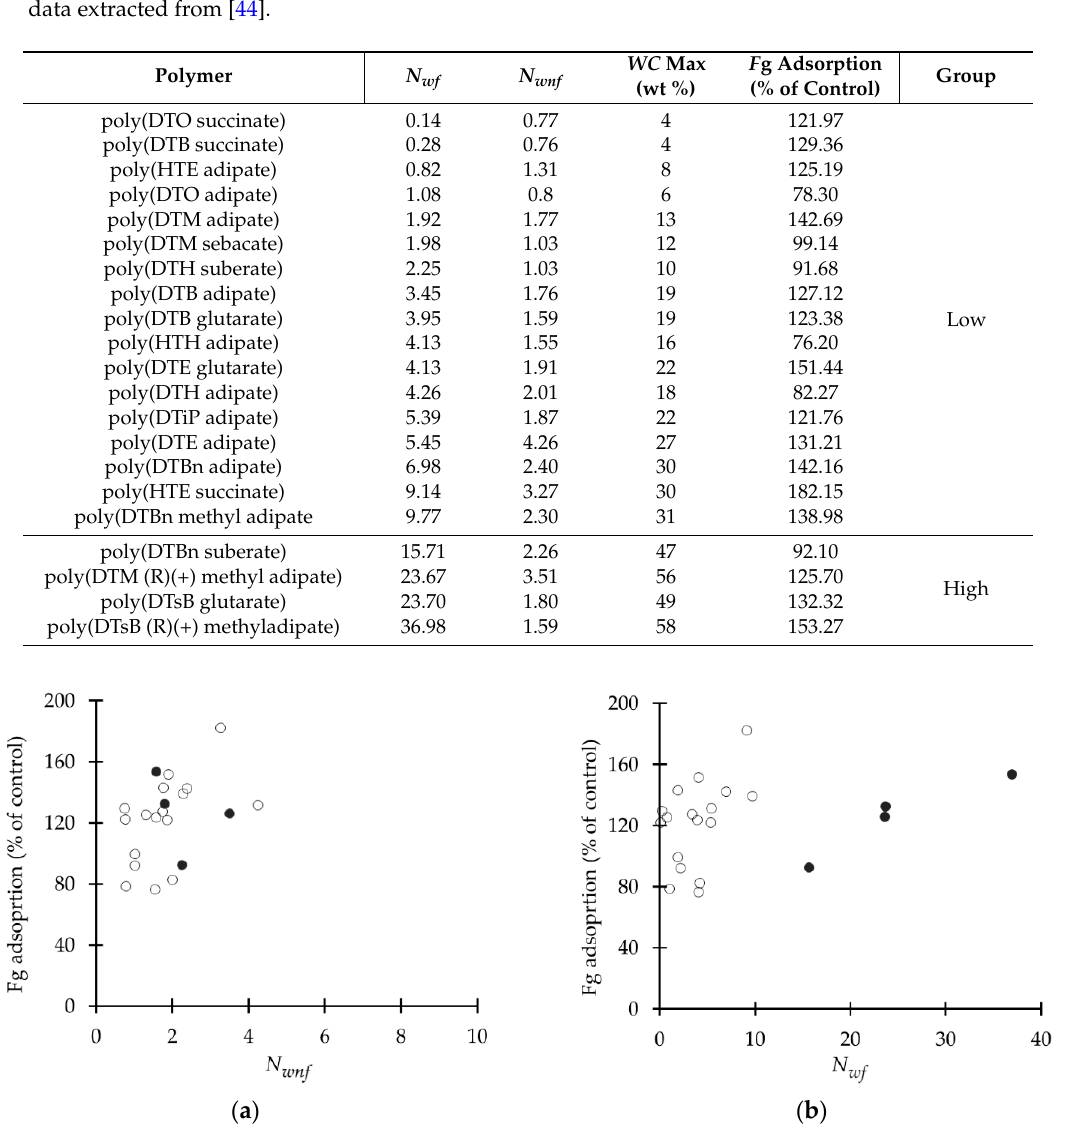
Figure 7. F g adsorption vs. N w in polyarylates ( a ): non-freezable water; ( b ): freezable water. ( • ) high WC , (o) low WC . X-axes are not in same